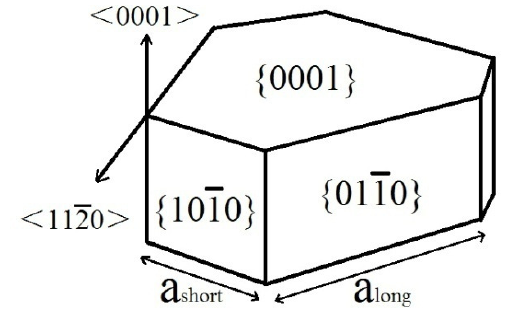
Figure 8. Schema of the WC grain shape in Co binder.